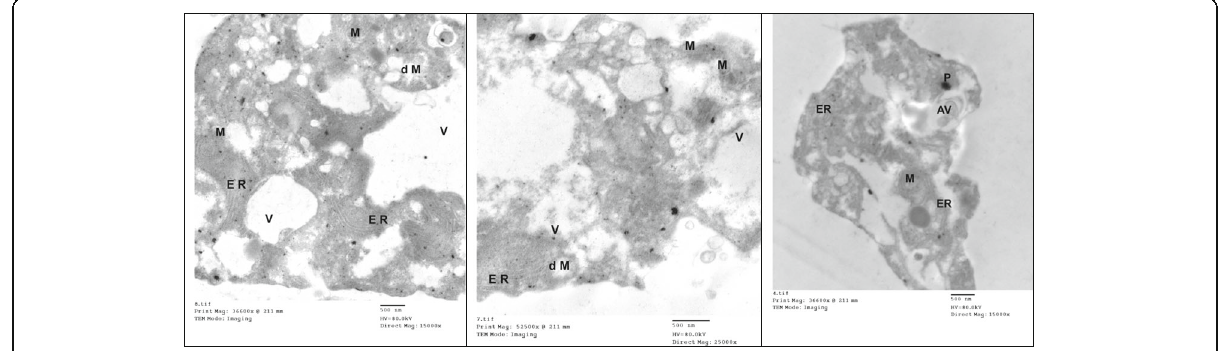
Fig. 7 Ultra-thin section in Allium cepa root tip meristems shows the effect of 3 h of direct treatment with 10.0% yeast extract on cell organelles: mitochondria (M), dilated mitochondria (dM), peroxisomes (P), and dilated endoplasmic reticulum (ER) in addition to vacuole (V) and